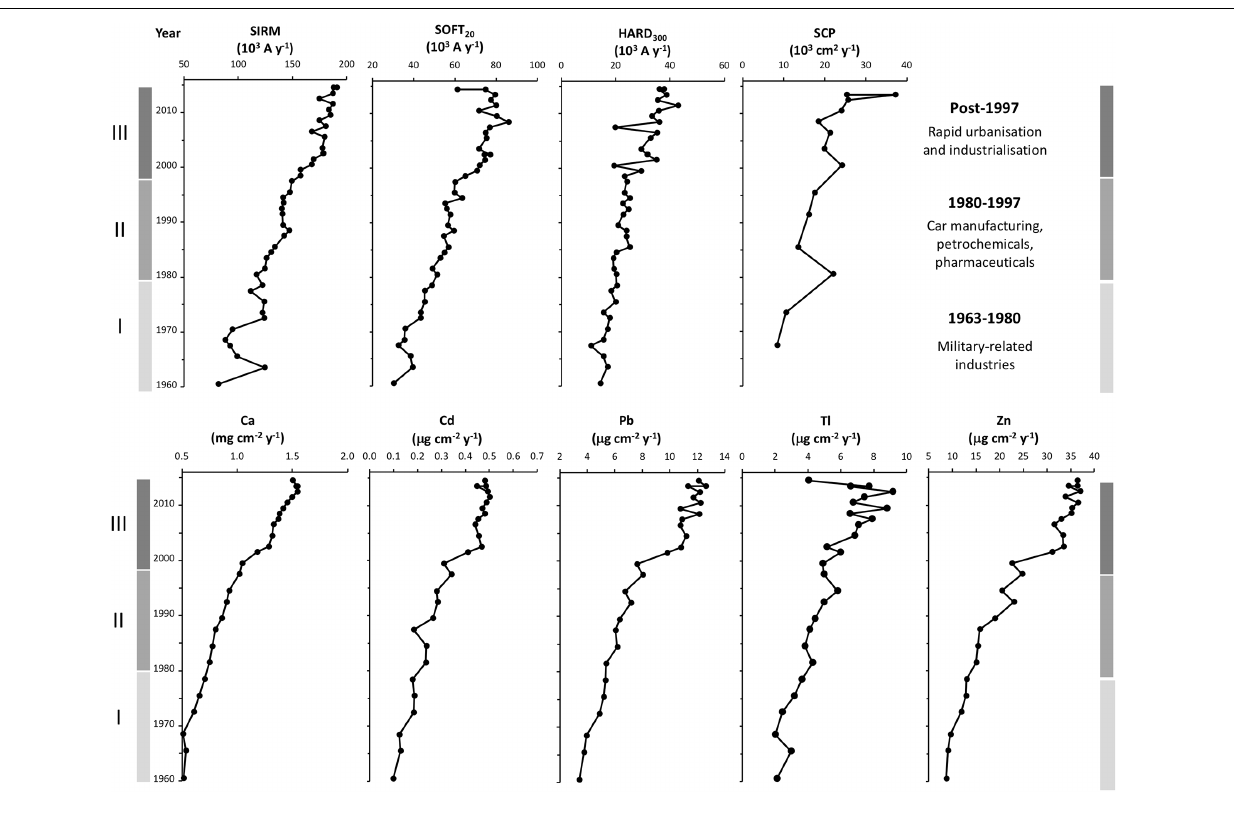
FIGURE 5 | Flux profiles for Sky Pond (SKP1) showing deposition of magnetic grains (SIRM, SOFT 20 , and HARD 300 ), SCPs and identified anthropogenic geochemical tracers: Ca, Cd, Pb, Tl, and Zn. Superimposed are distinct phases identified from the flux profiles, which relate to the urban history of